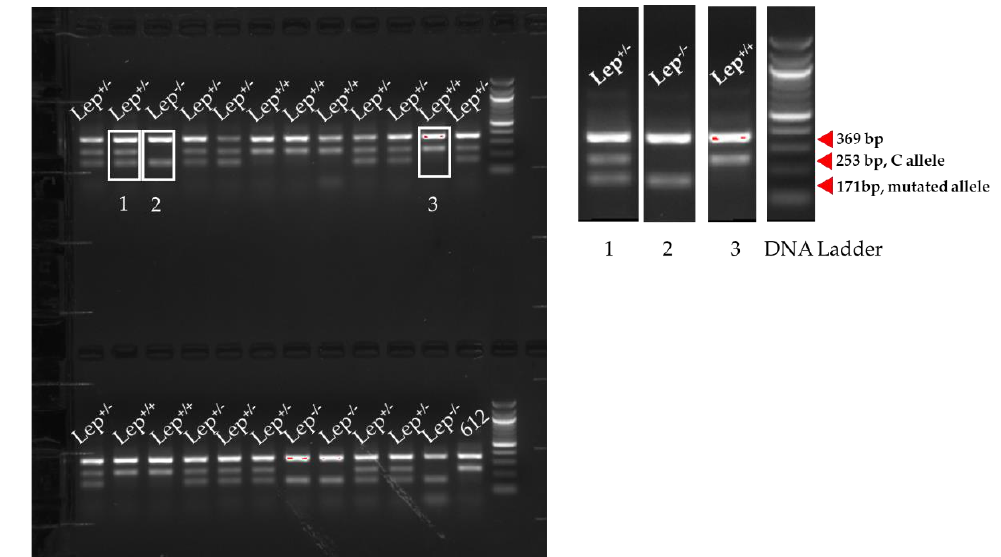
Figure 3. Tetra-primer ARMS-PCR was conducted on DNA samples collected from mice, followed by gel electrophoresis. Each lane represented one specific sample. Quick-Load ® 100 bp DNA Ladder (New England Biolabs, Ipswich, MA, USA) was used as the reference to visualize the difference in the positions of the amplicons on a 1.5% agarose gel. A zoomed insert was provided to elucidate the size and pattern of PCR amplicons corresponding to three different genotypes. 1.Lep+ /− : heterozygous mouse carrying a mutated allele (T allele, 171 bp), 2. Lep −/− : ob / ob mouse (carrying T on both alleles), 3. Lep+/+: wildtype mouse (carrying C on both alleles, 253 bp). Red arrow indicates the size of specific band on the gel. Sample 612 was collected from a db/db mouse, which served as a wild-type control for the leptin gene.